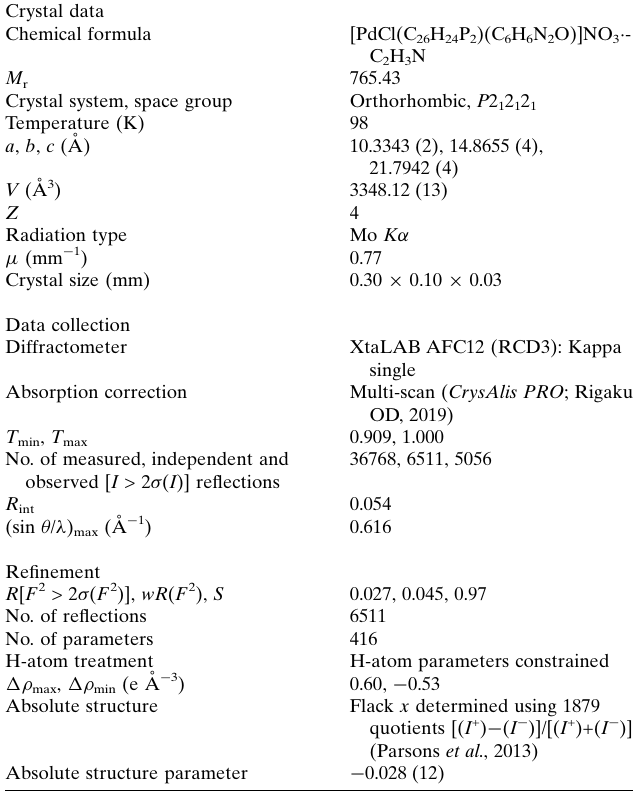
Table 3 Experimental details. Crystal data Chemical